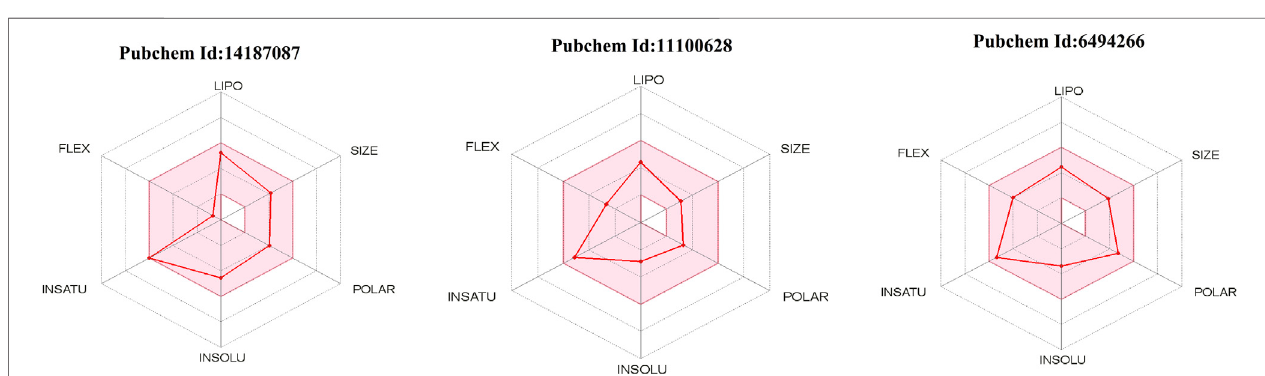
FIGURE 6 | Radar of oral bioavailability (shown by red line). The pink-colored zone presents the physicochemical space allowed for orally bioavailable drugs. INSATU (instauration), INSOLU (insolubility), LIPO (lipophility), POLAR (polarity), FLEX ( fl exibility), and SIZE (molecular weight).